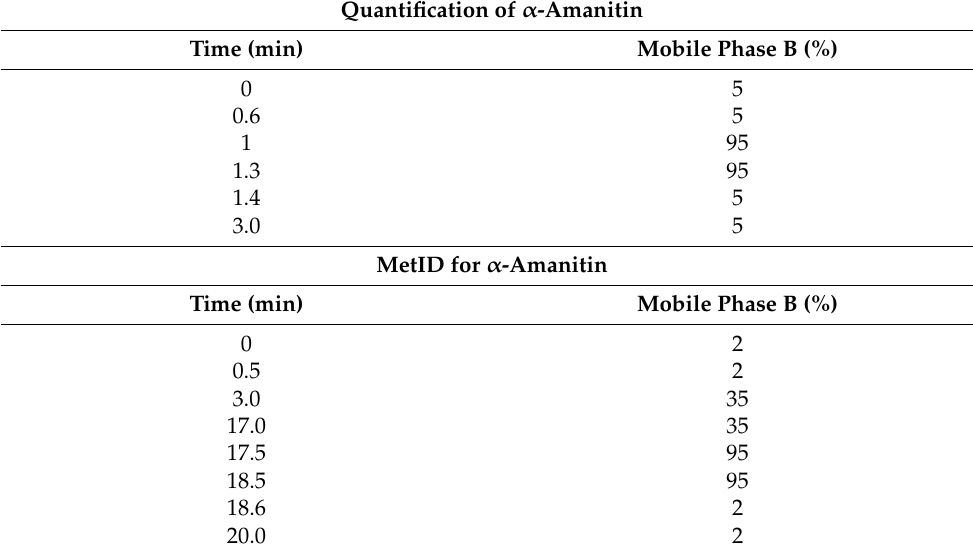
Table 9. Mobile phase conditions for LC